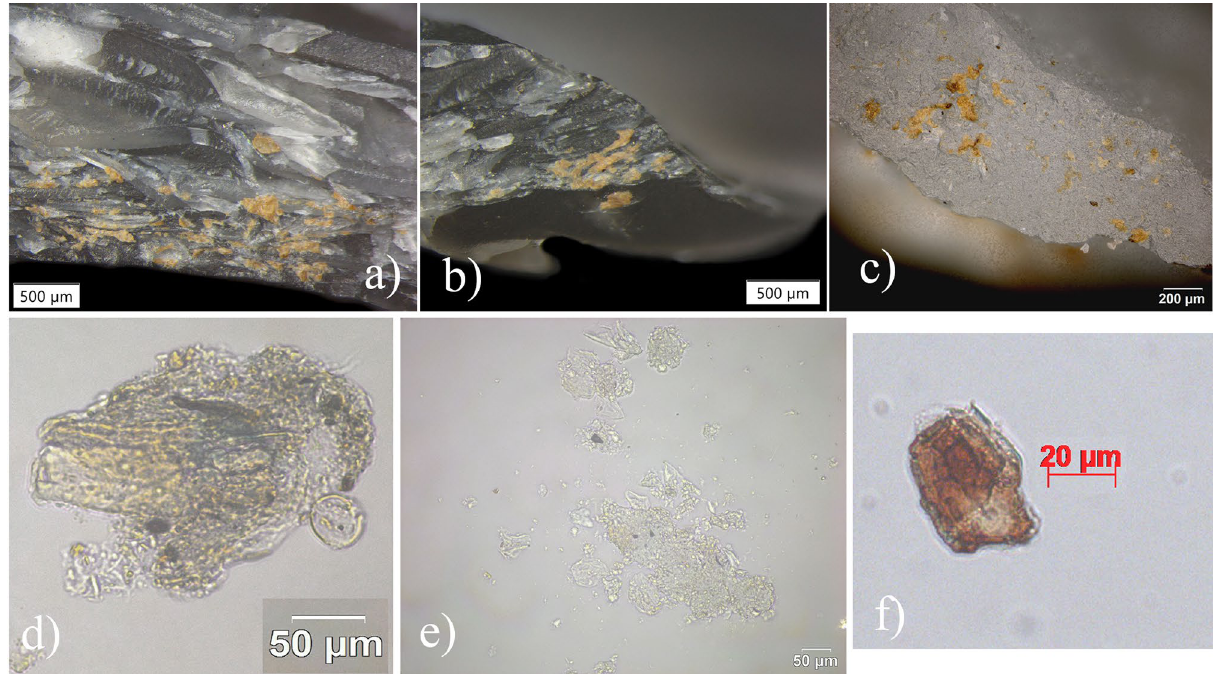
Figure 4. Archeological macro and microscopic residues identified on the lithic artifacts from the elephant area at Schöningen 13 II-3. ( a–c ) macroscopic use-related residues embedded and smeared in the retouch scars of the resharpening flakes ID 30251, ID 29716 (Magnification: 56x) and on the butt of resharpening flake ID 30255 (Magnification: 200x); ( d–f ) extracted micro-use related residues consisting of wood tissues and cortex